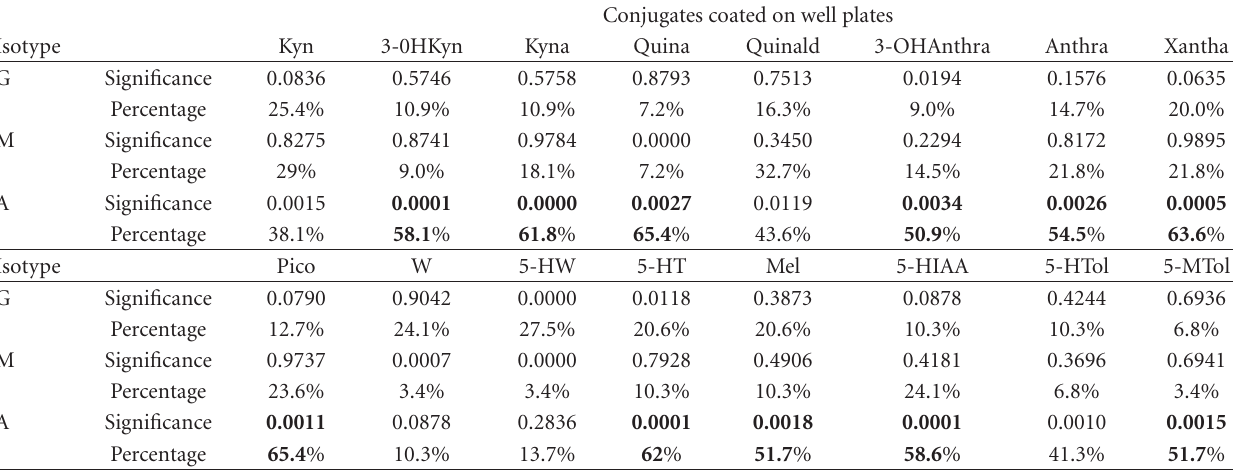
Table 1: Significance ( P ≤ . 01) of OD values (U Mann and Whitney t -test) and percentage of AD positive patients on well plates coated with tryptophan-derivative conjugates. OD values for each tryptophan-derivative conjugate were subtracted from those on BSA well